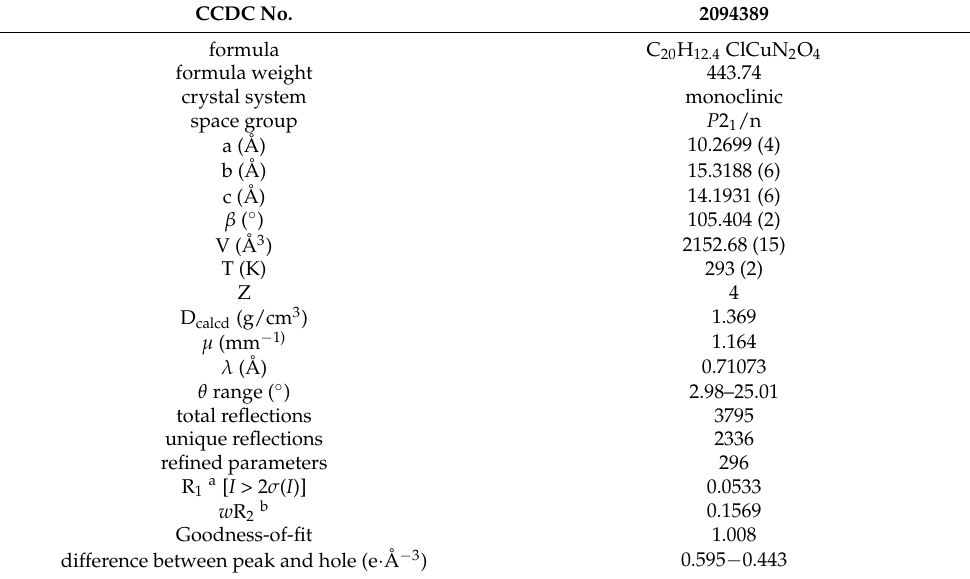
Table 1. Crystal data and refinement parameters for